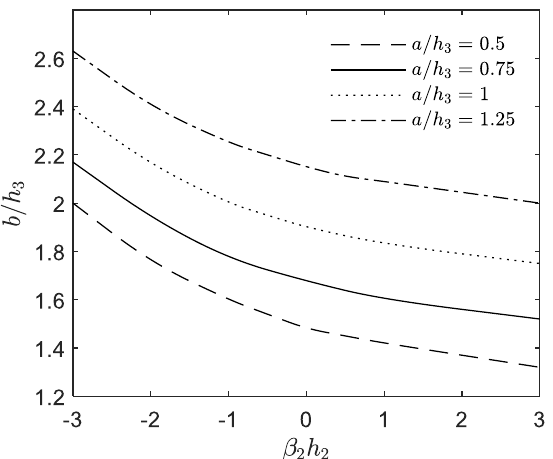
h  on the non – dimensionalized receding 2 2